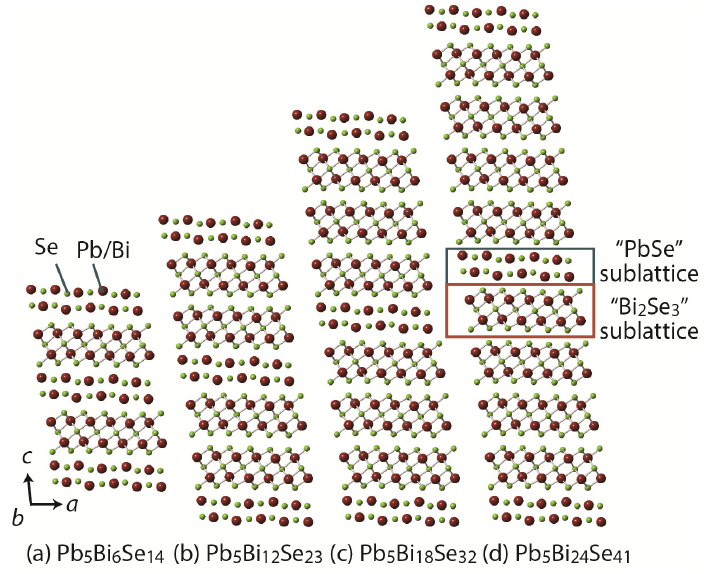
Figure 9. Structural evolution in the cannizzarite homologous series [(PbSe) 5 ] m [(Bi 2 Se 3 ) 3 ] n : ( a ) Pb 5 Bi 6 Se 14 ( m = 1, n = 1); ( b ) Pb 5 Bi 12 Se 23 ( m = 1, n = 2); ( c ) Pb 5 Bi 18 Se 32 ( m = 1, n = 3); and ( d ) Pb 5 Bi 24 Se 41 ( m = 1, n = 4) [33,95,97]. The sizes of atoms in this figure are